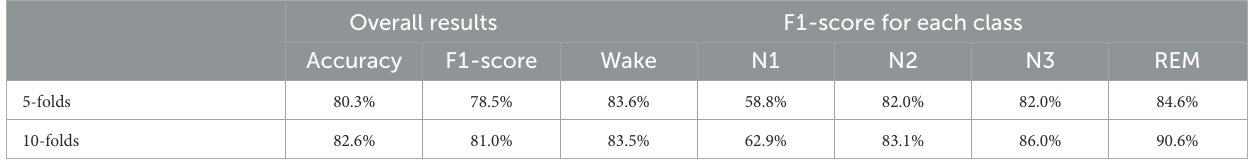
TABLE 4 Cross-validation of different fold numbers on the ISRUC-S3